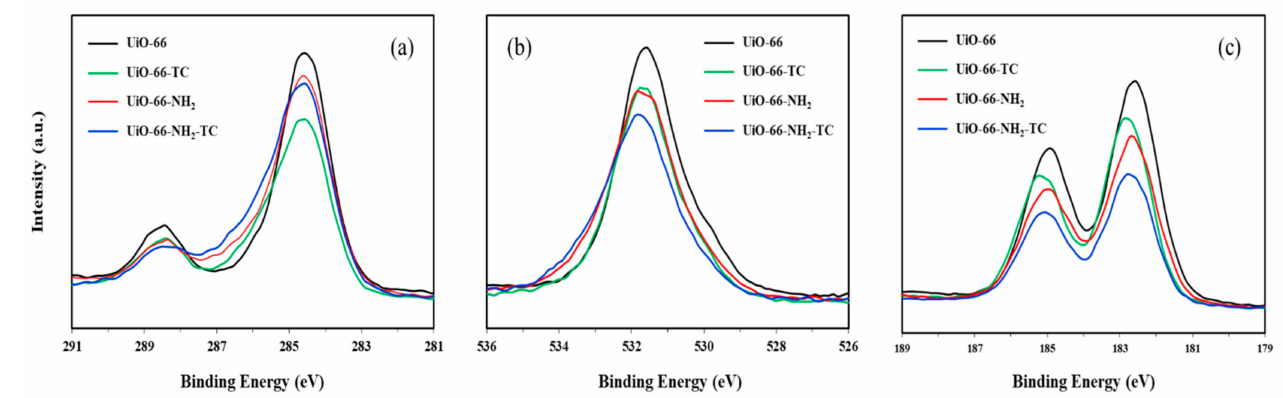
Figure 2. XPS spectra of UiO-66 and UiO-66-NH 2 before and after adsorption for ( a ) C1s, ( b ) O1s, ( c )